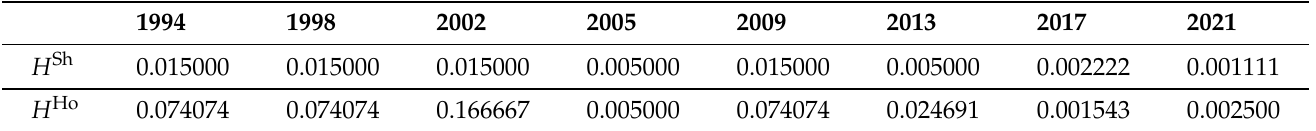
Table 6. Results for German federal parliament in